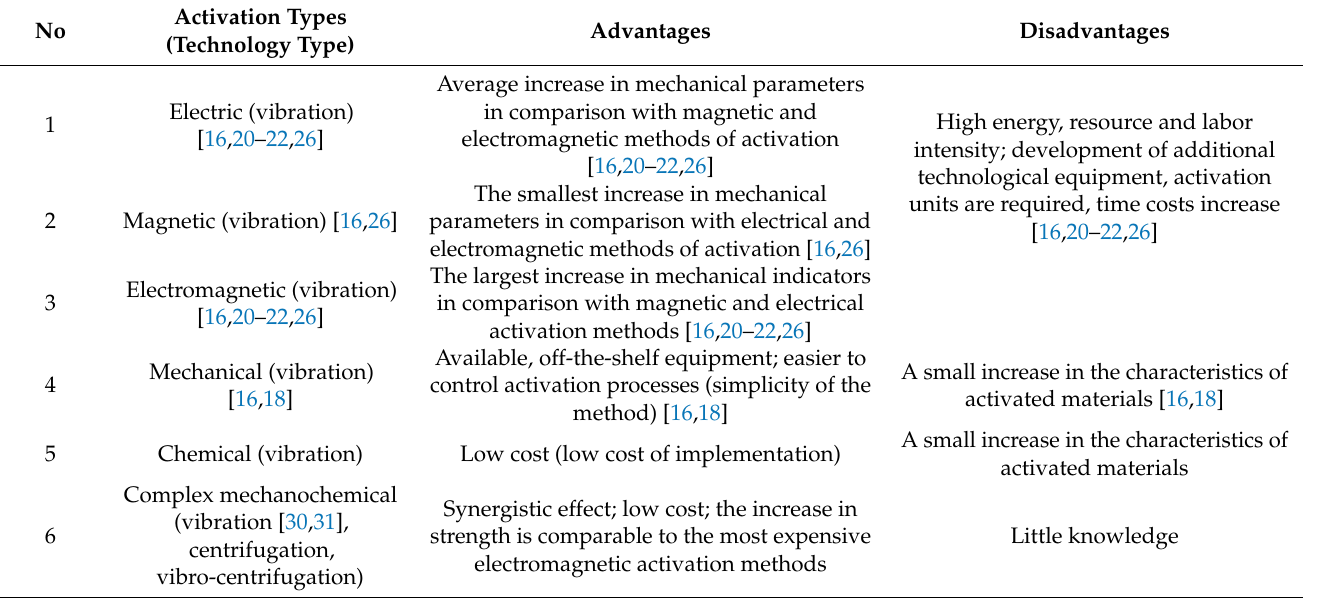
Table 9. Comparison of activation